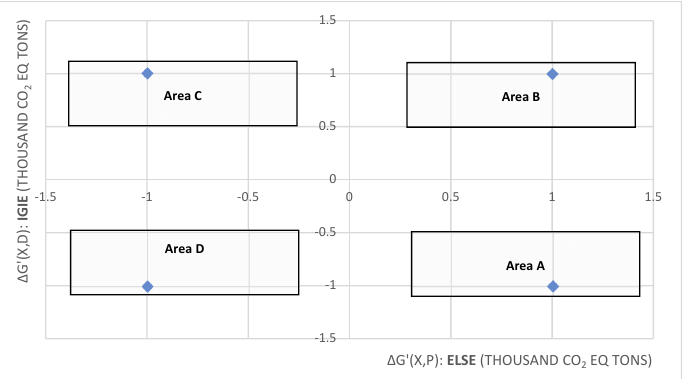
Figure 2. Classification coordinate of industrial sectors.